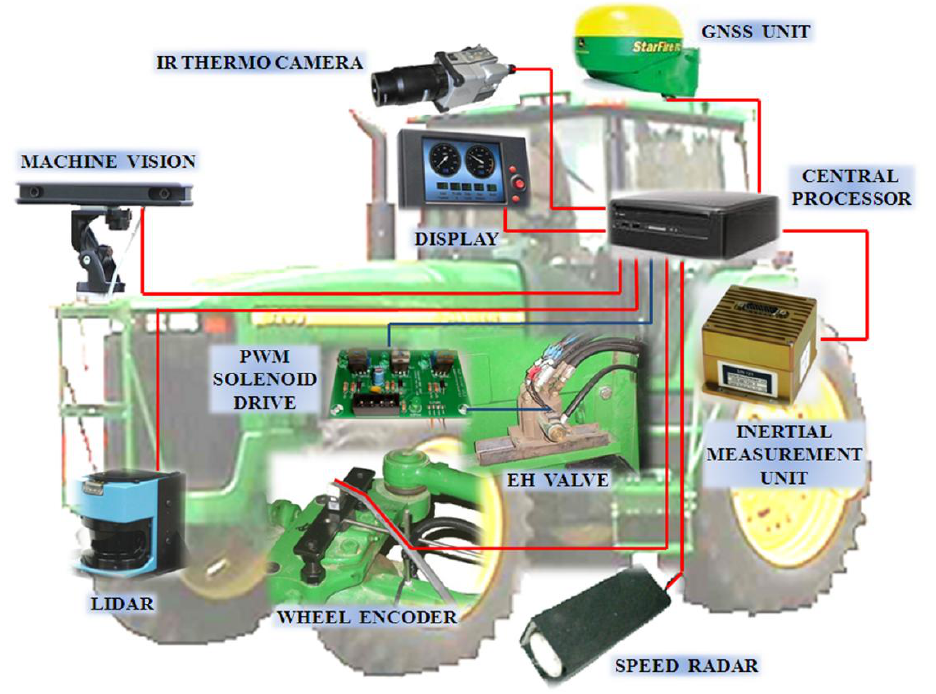
Figure 12. Generic sensor network for an intelligent agricultural